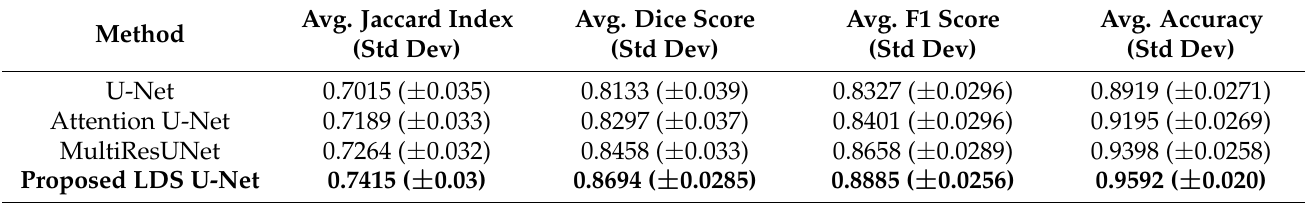
Table 2. Quantitative performance evaluation of various